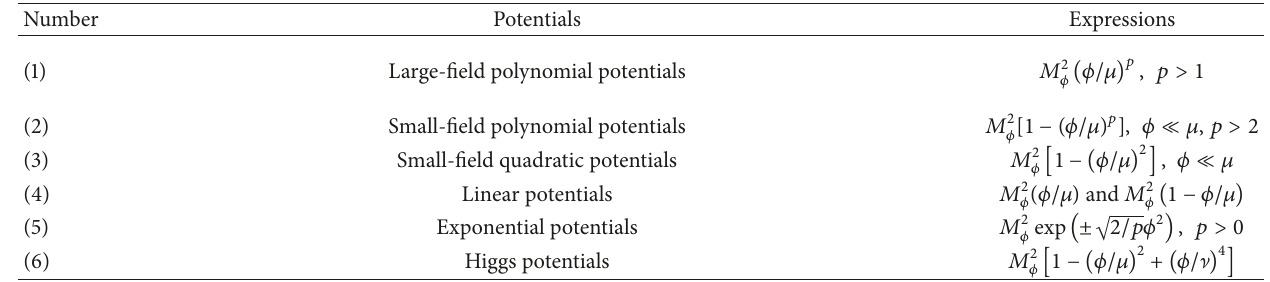
Table 1: Scalar field potentials.